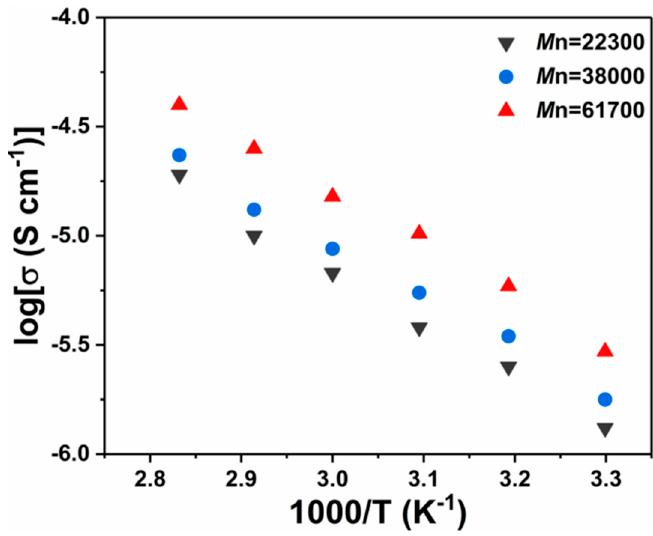
Figure 5. Ionic conductivity of P(EO-PEGMA)/PVDF polymer electrolyte with P(EO-PEGMA) with different molecular weights.